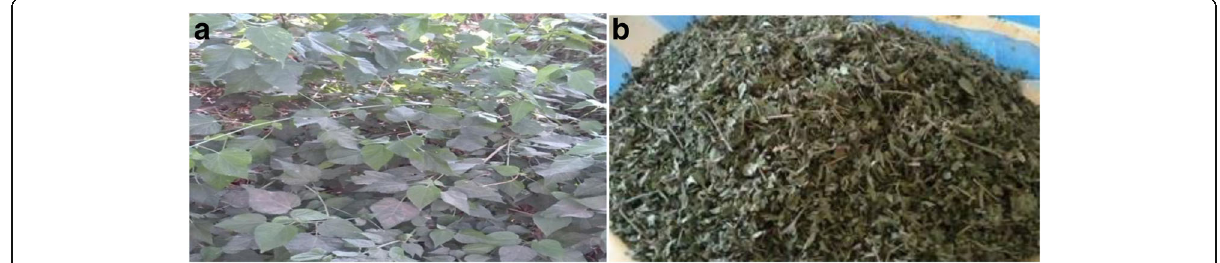
Fig. 1 Images of Hibiscus micranthus Linn. ( a ) Plant ( b ) Coarse dried